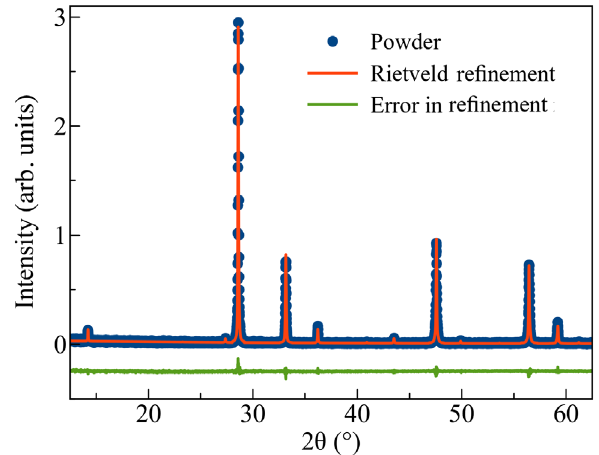
FIG. 12. Powder x-ray refinement of the La 2 Zr 2 O 7 sample synthesized for this work. The difference between the measured and calculated diffraction patterns is shown in green and indicates phase purity; this line has been shifted downward by 0.25 units for